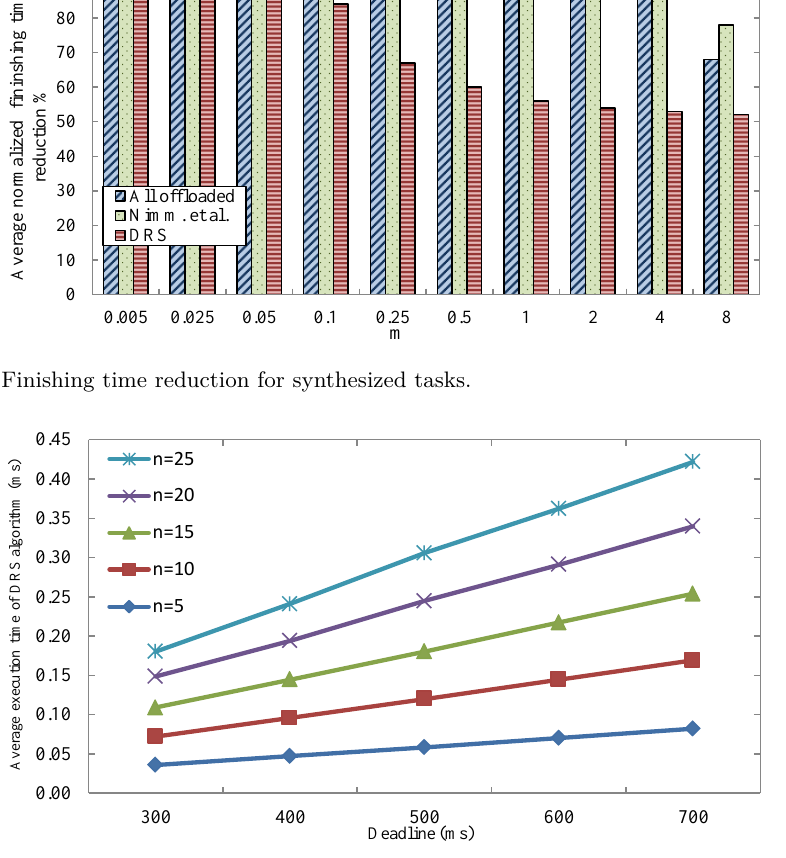
Figure 12 Execution time of DRS